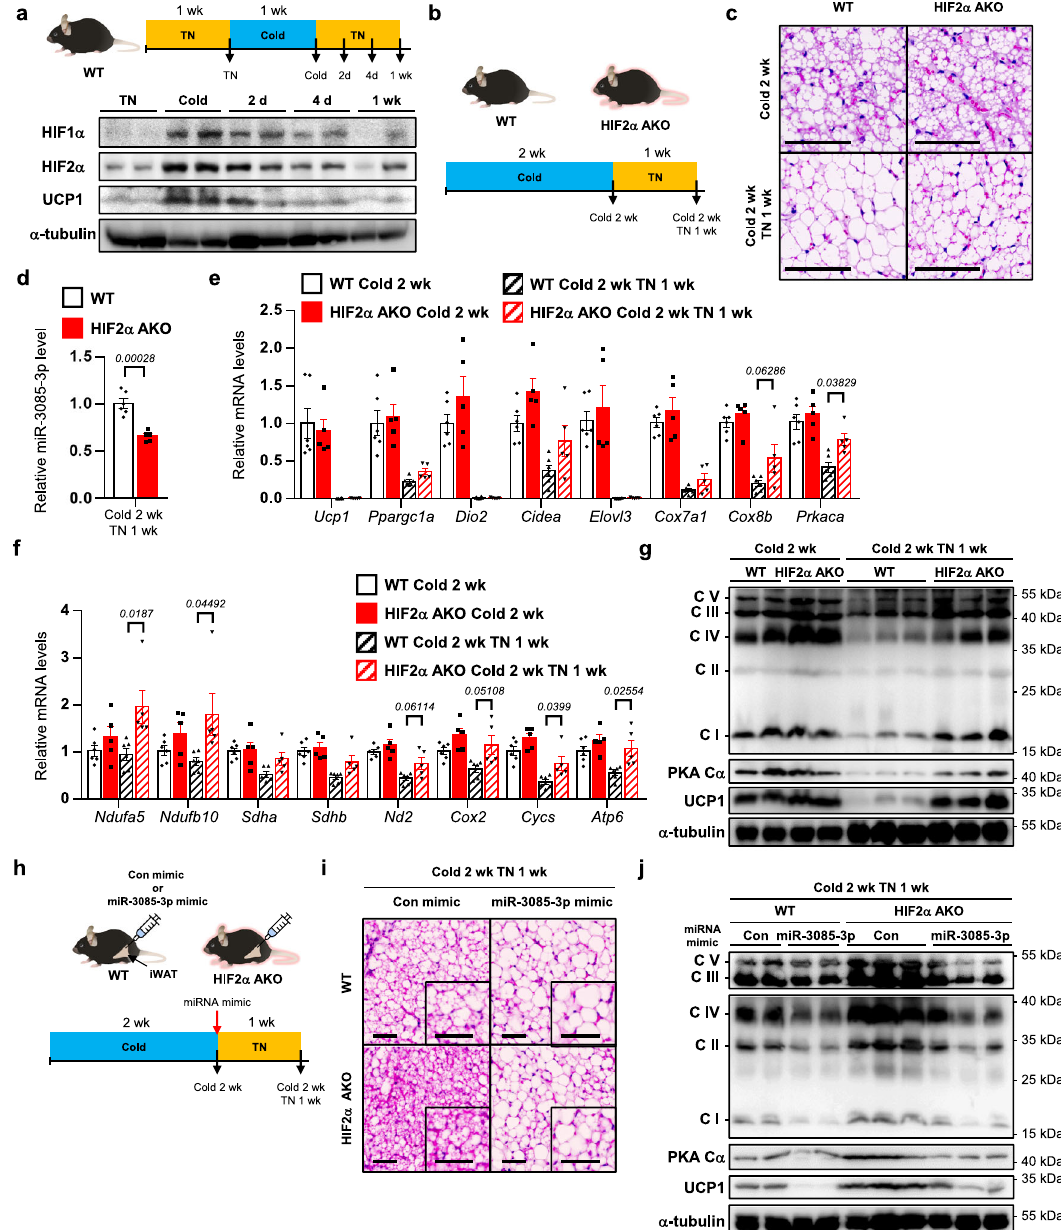
Fig. 7 During the re-warming process, adipocyte HIF2 α de fi ciency fails to mitigate the mitochondrial activity. a Experimental scheme (top) and western blot analysis of HIF α and UCP1 in iWAT of upon cold exposure or re-warming (bottom). b Experimental scheme of re-warming. c Representative images of H&E staining of iWAT from WT and HIF2 α AKO mice upon cold exposure or re-warming (cold 2 weeks + TN 1 week). Scale bars, 100 μ m. d miR-3085-3p level of iWAT from WT ( n = 6) and HIF2 α AKO ( n = 5) mice upon cold and re-warming (cold 2 week + TN 1 week). e , f mRNA levels in iWAT from WT ( n = 6) and HIF2 α AKO ( n = 5) mice upon cold exposure and re-warming (cold 2 weeks + TN 1 week). g Western blot analysis of OXPHOS complexes, PKA C α , and UCP1 in iWAT from WT and HIF2 α AKO mice upon cold exposure and re-warming (cold 2 weeks + TN 1 week). h Experimental scheme of re- warming with con or miR-3085-3p mimic injection. i Representative images of H&E staining of iWAT from WT and HIF2 α AKO mice upon re-warming (cold 2 weeks + TN 1 week) with con or miR-3085-3p mimic injection. Scale bars, 50 μ m. j Western blot analysis of OXPHOS complexes, PKA C α , and UCP1 in iWAT from WT and HIF2 α AKO mice upon re-warming (cold 2 weeks + TN 1 week) with con or miR-3085-3p mimic injection. Data were expressed as the mean ± SEM by two-tailed unpaired Student t -tests in ( d ) or two-way ANOVA in ( e , f ) followed by Holm – Sidak ’ s multiple comparisons test. Prkaca 3 ′ UTR target miRNA prediction and validation . TargetScan mouse 7.2 64 Adenovirus infection . HIF1 α and HIF2 α adenoviruses were generously provided by Dr. Jang-Soo Chun (Gwangju Institute of Science and Technology, Gwangju, and miRDB Version 6.0 65 were used to predict miRNA candidates targeting Prkaca South Korea). Green fl uorescent protein-containing adenovirus was used as a 3 ′ UTR. For luciferase assays, pGL3UC-Prkaca 3 ′ UTR WT or pGL3UC-Prkaca 3 ′ negative control (mock). Four days after differentiation, beige adipocytes or BACs UTR Mut. construct was transfected with control or miR-3085-3p mimic into were incubated with DMEM containing 10% FBS and adenovirus (at a multiplicity HEK293FT cells using Lipofectamine 3000 (L3000001, Thermo Fisher Scienti fi c). of infection of 500) for 16 h. The culture medium was replaced with fresh medium After 24 h of transfection, cell lysates were analyzed for luciferase activity. A for 2 days. pCMV- β -galactosidase plasmid was used as an internal control for transfection